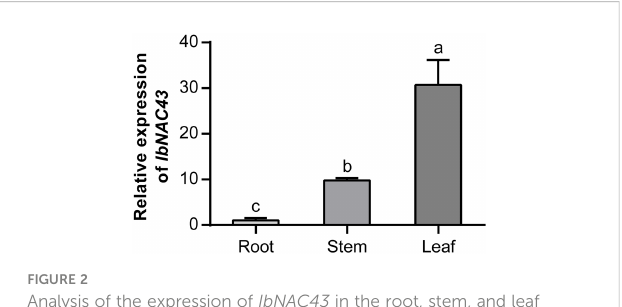
FIGURE 2 Analysis of the expression of IbNAC43 in the root, stem, and leaf tissues of Shangshu 19. Data are presented as the mean ± SE ( n = 3). Different lowercase letters indicate signi fi cant differences ( p < 0.05, one-way